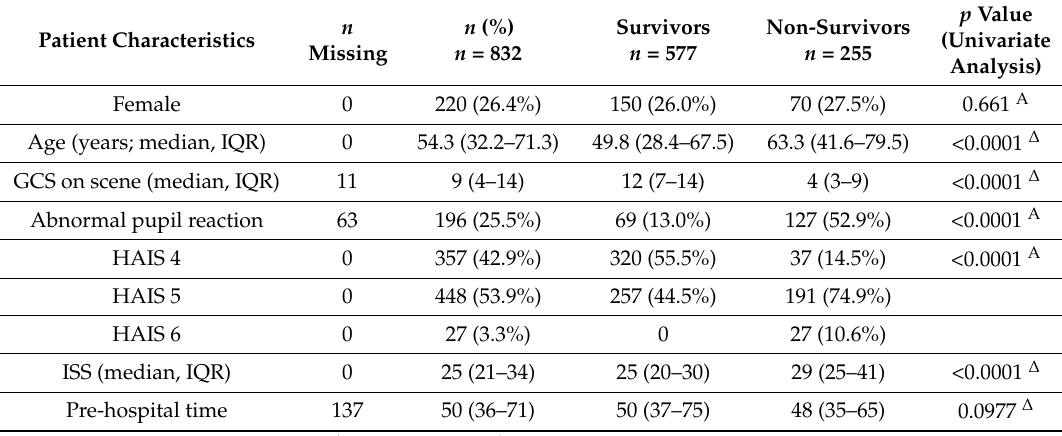
Table 1. Description of surviving and non-surviving patients with severe traumatic brain injury at 14 days.